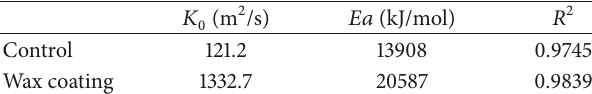
Table 2: Estimated parameter values for the kinetic model in (5).